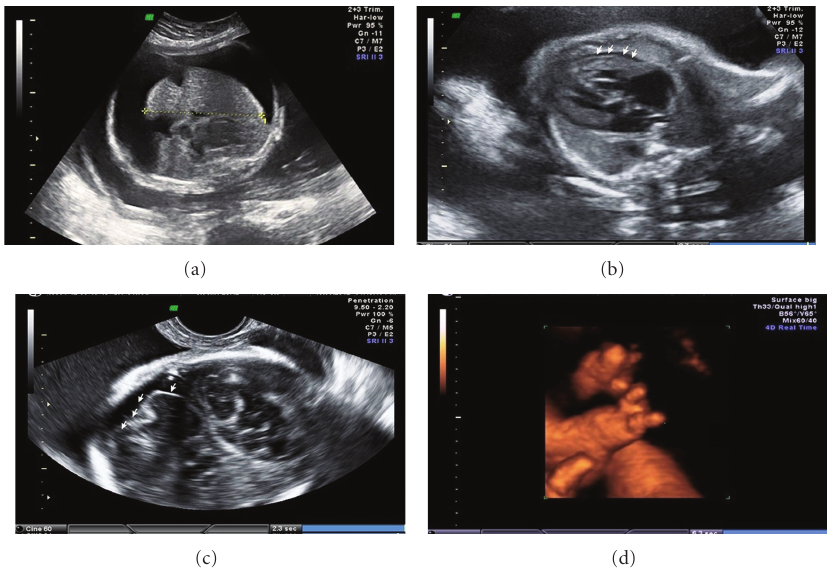
Figure 1: (a) Axial plane of the fetal abdomen on 2DUS, showing ascites and hepatomegaly. (b) Axial plane of the fetal thorax on 2DUS at the level of the four chambers of the heart, showing pericardial e ff usion (white arrows). (c) Sagittal plane of the fetal cranium on 2DUS, showing hyperechogenicity of the cerebral parenchyma. (d) Three-dimensional image in rendering mode, showing twisting and absence of some